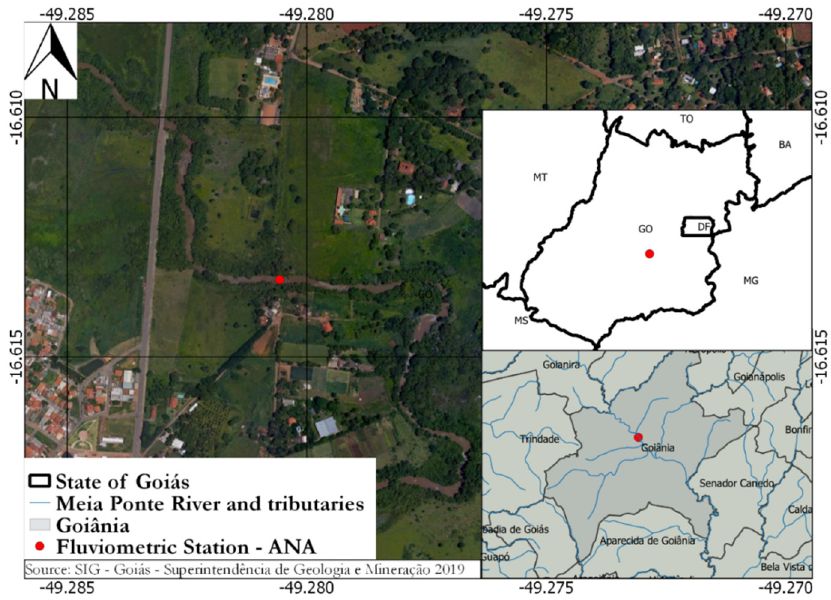
Figure 1. Meia Ponte River’s and study